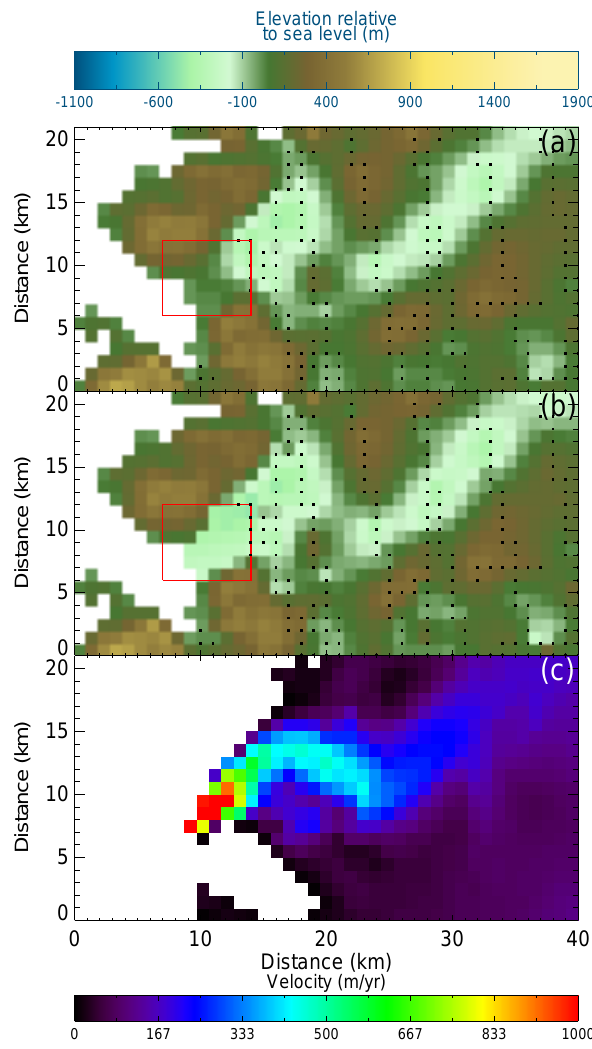
Fig. 2. (a) Outlet glacier on the north-west coast before the mass conservation approach was applied. Red box outlines the area where the mass conservation approach altered the bed elevations. The lo- cation of the region is shown in the blue rectangle in Fig. 3. (b) Bed elevation after mass conservation has been applied in the topograph- ically constrained fast flow region. (c) Ice surface velocity resam- pled to 1km postings (Joughin et al., 2010). Bed elevations in all plots are with respect to the EIGEN-GL04C